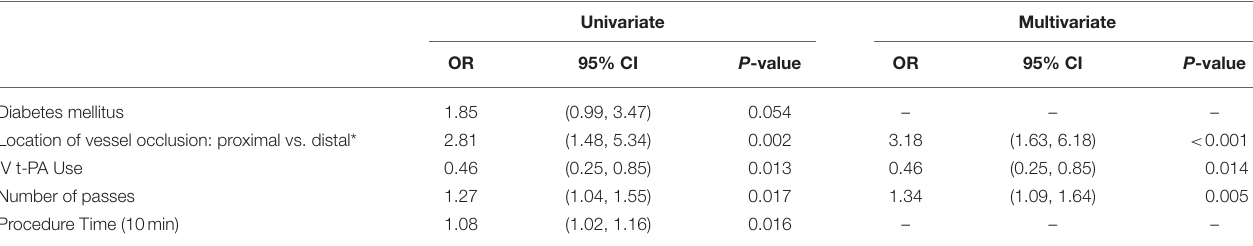
TABLE 2 | Predictors of post-thrombectomy SAH—multivariate logistic regression for anterior circulation vessel occlusions. Univariate